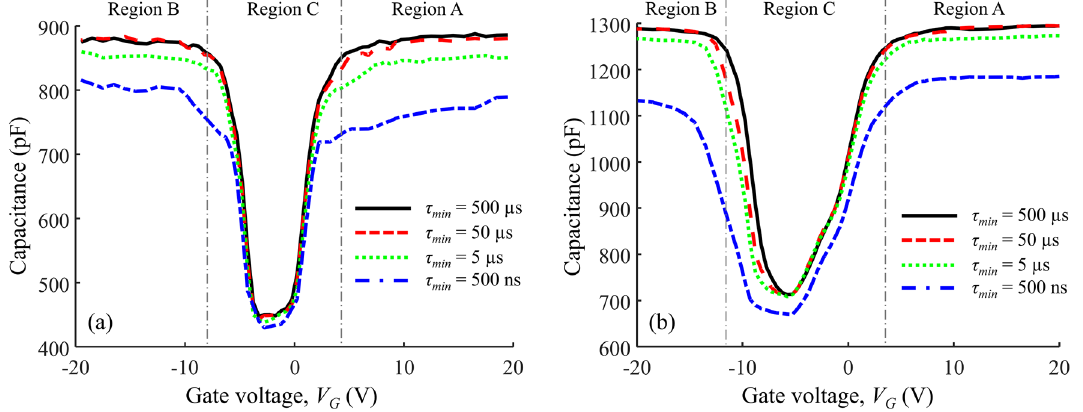
Figure 4. Capacitance–voltage curves of commercial N channel SiC Power MOSFETs for ( a ) manufacturer A, and ( b ) manufacturer